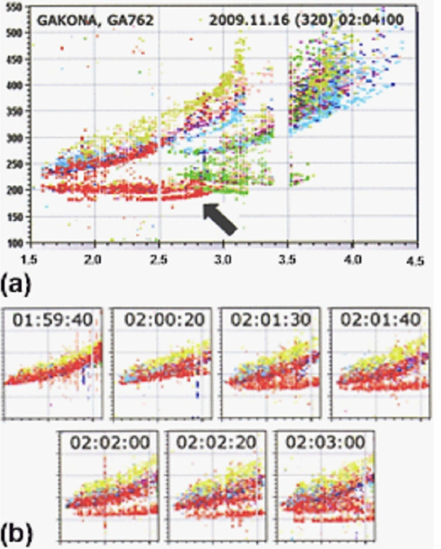
Figure 4. Ionograms of digisonde echoes recorded on 16 November 2009 during HF heating experi- ment at High-Frequency Active Auroral Research Program (HAARP). ( a ) An additional echo trace (pointed by an arrow) appears below the normal echo trace. It signifies artificial ionization structures, and ( b ) a sequence of seven ionograms recorded from 01:59:40 to 02:03:00 showing the generation and evolution of the artificial ionization structures. Courtesy of Bo